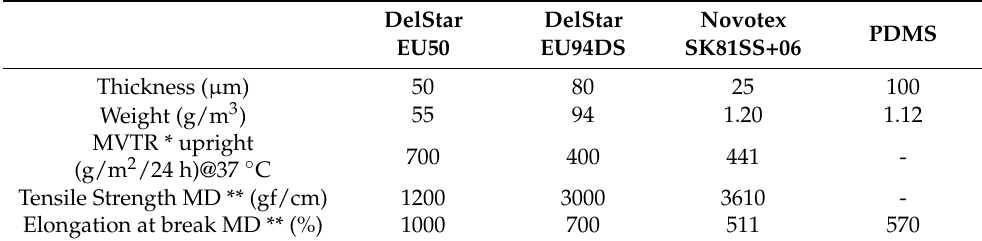
Table 4. Characteristics of the films.